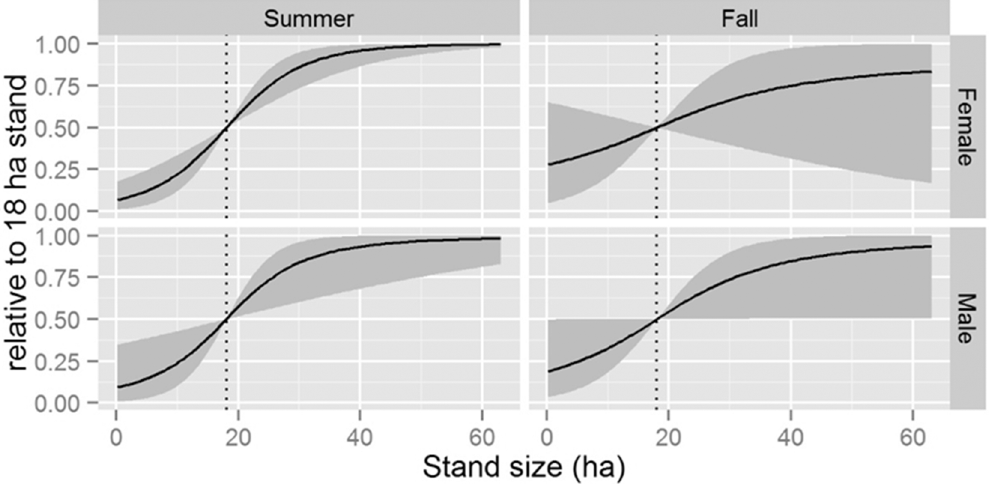
Fig 3. Predicted probability of selecting a roost as a function of stand size for male and female Indiana bats ( Myotis sodalis ) in summer and fall months in Fort Drum, NY, USA between 2007 – 2011. Solid lines indicate mean posterior probability of use and gray ribbons represent the limits of 95% credible intervals. Each panel assumes bats are faced with a choice of 2 potential roosts: one fixed at the observed mean stand size (vertical dashed line) and the other represented by the value of the x -axis. All other variables are assumed constant.